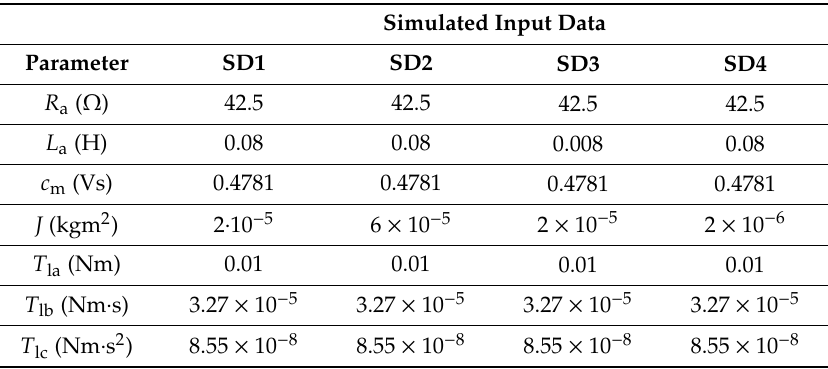
Table 3. Parameters used to get simulated